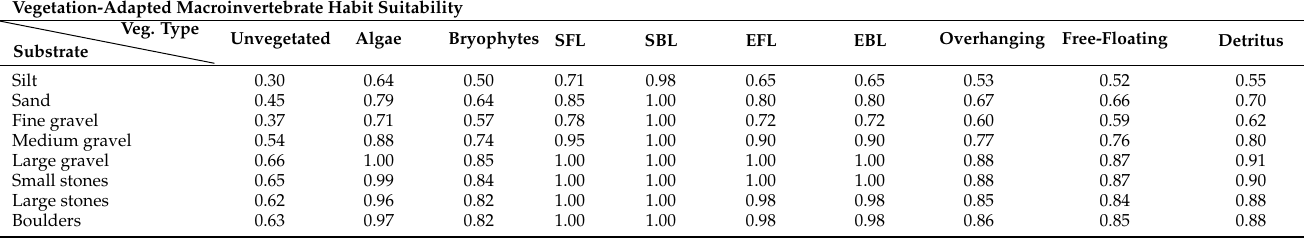
Table 3. Habitat suitability (0: totally unsuitable; 1: totally suitable) for emergent and submerged vegetation types in combination with the inorganic bottom substrate type. Unvegetated means the habitat suitability of the inorganic substrate type without any vegetation. For each vegetation type, the habitat suitability was added to that of the inorganic substrate, e.g., SFL in silt (0.71) means that the habitat suitability for SFL is 0.71 − 0.30 =